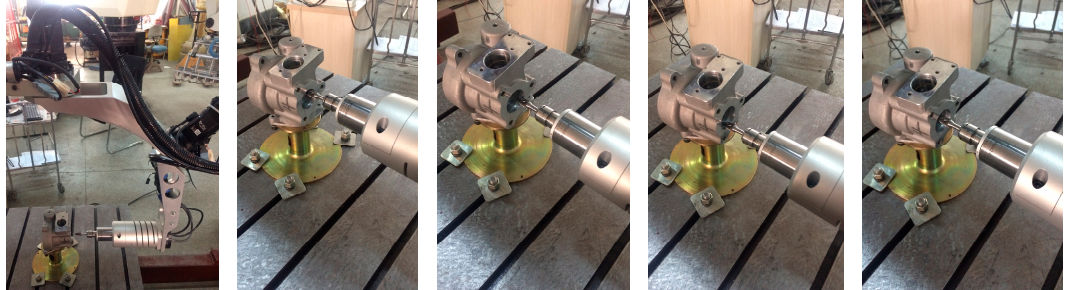
Figure 23. Experimental deburring of facet edges on top facet.